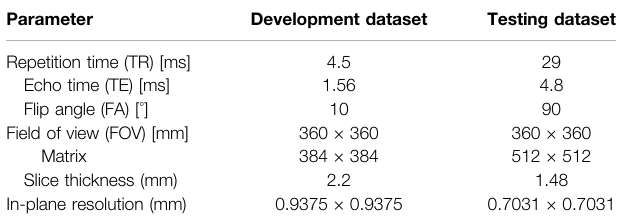
TABLE 1 | Imaging parameters in the development and testing datasets.